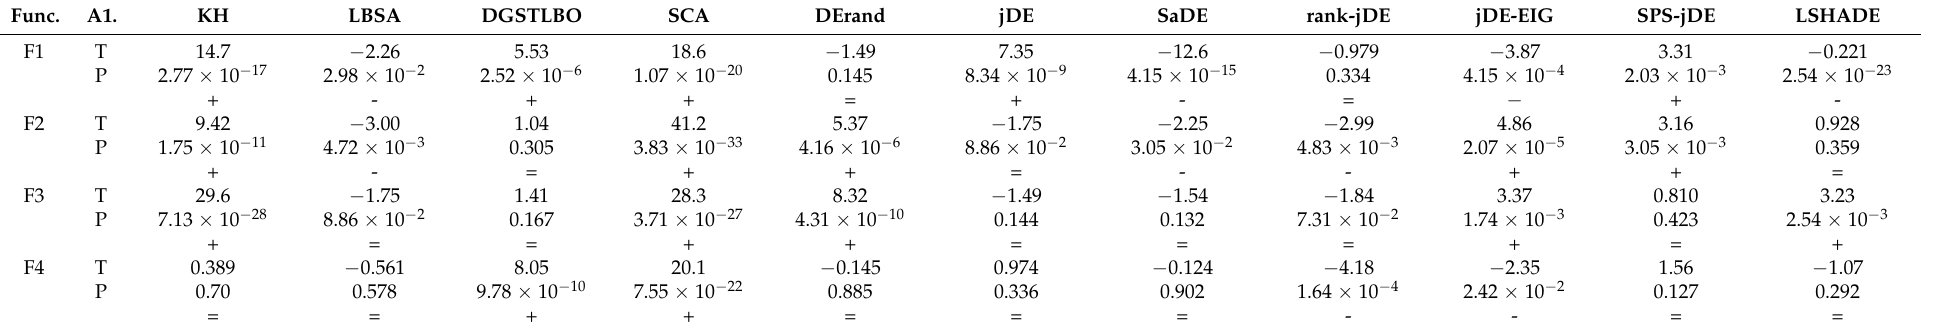
Table 5. Comparison between RUSDE and other algorithms using a t -test with double tail for 50-dimensional problems.